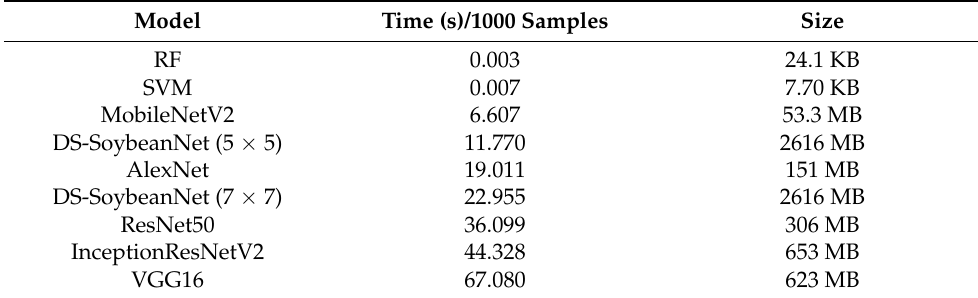
Table 11. Models’ elapsed times and